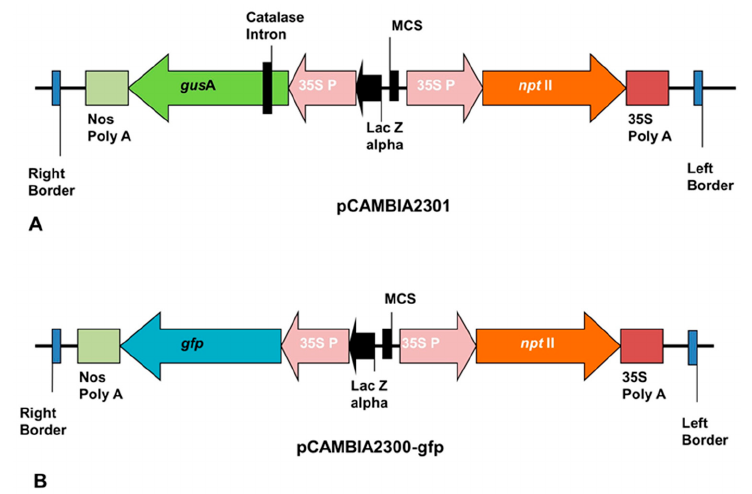
Figure 7. Map of plasmid construct. ( A ) pCAMBIA2301; ( B ) pCAMBIA2300- gfp.